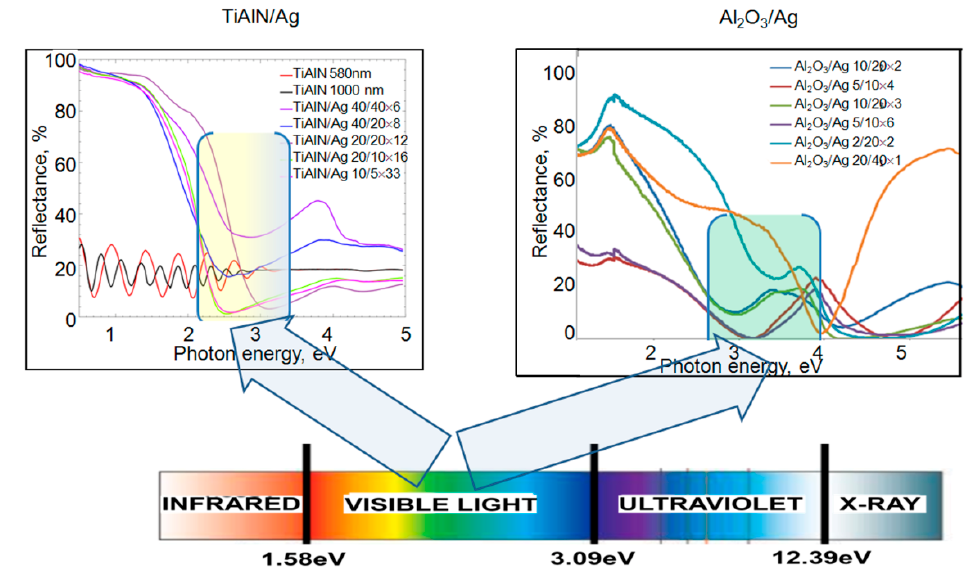
Figure 5. Reflection spectra of multilayer TiAlN/Ag and Al 2 O 3 /Ag nanocomposites with various architectures given on inserts.